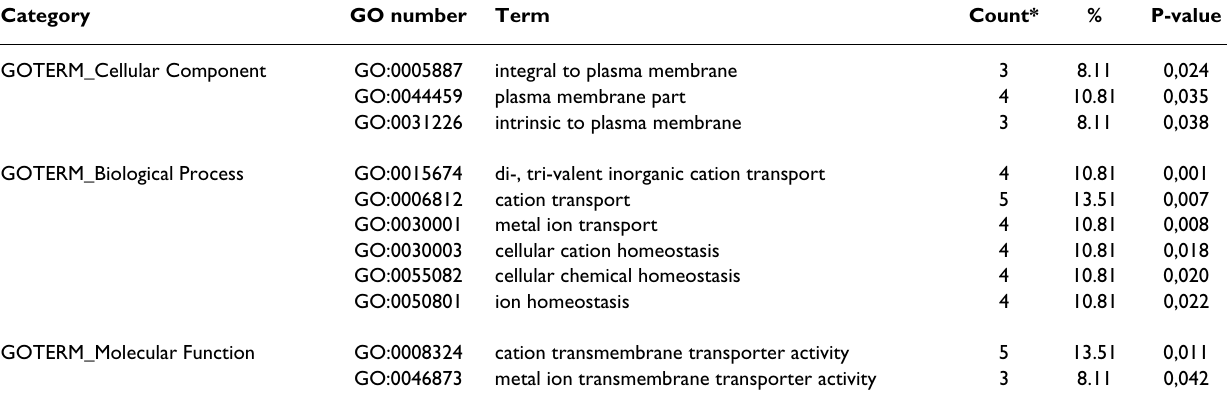
Table 4: Enriched Gene Ontology Groups in the restrictive-temperature experiment Category GO number Term Count* GOTERM_Cellular